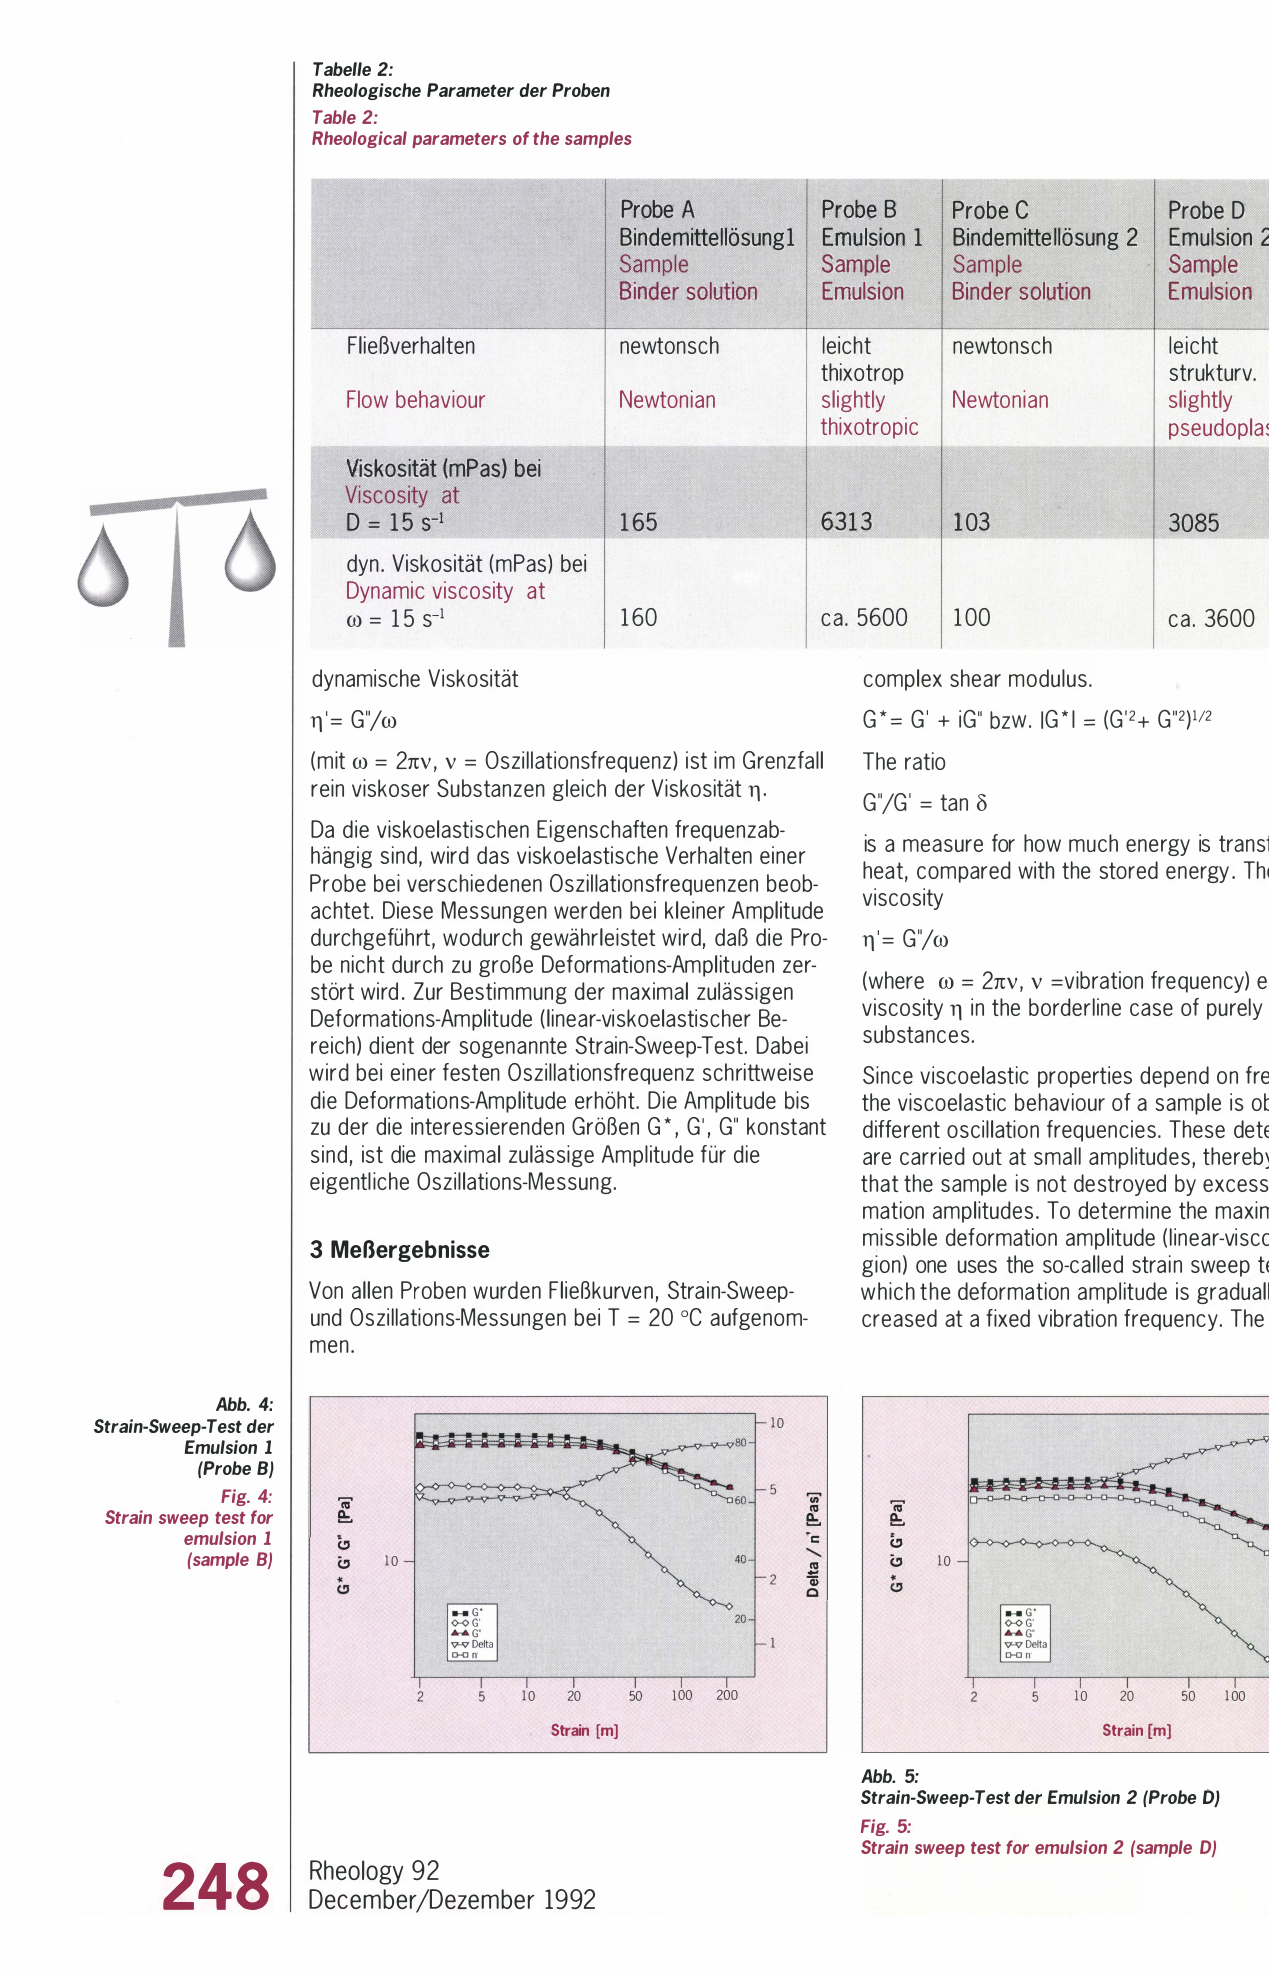
Tabe/le 2: Rheologische Parameter der Proben Table 2: Rheological parameters of the samples